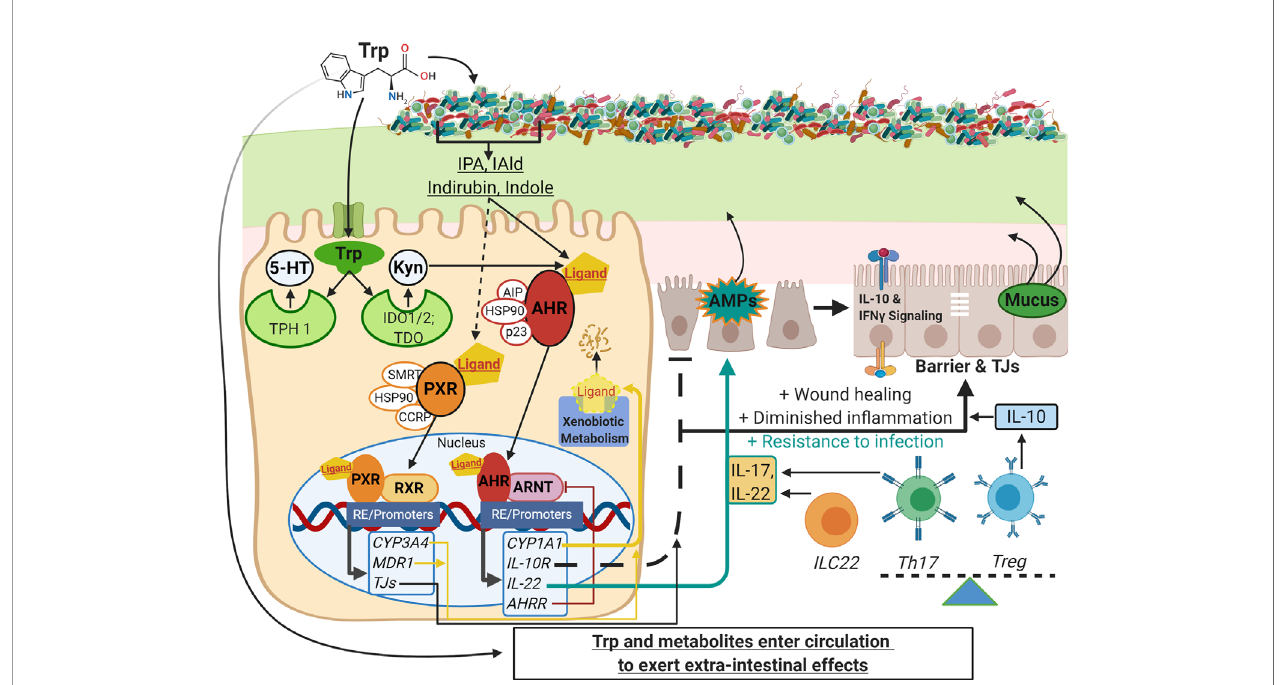
FIGURE 1 | Schematic of Trp metabolism, signaling pathways, and modulation of IEC and immune cell functions. On the left side, Trp enters host cells through various amino acid transporters and is metabolized endogenously: TPH1 (or TPH2 in the periphery) is the rate-limiting enzyme in conversion to 5-HT, and IDO and TDO enzymes convert Trp into Kyn. Gut microbes synthesize Trp de novo and convert this essential amino acid to numerous metabolites such as IPA, IAld, and indirubin. These metabolites, as well as endogenous Trp metabolites like Kyn, are shown to bind the ligand-activated transcription factor AHR and in some cases bind the transcription factor PXR. Both AHR and PXR are bound to chaperone proteins in the cytosol and ligand binding triggers nuclear translocation, heterodimer formation with either ARNT or RXR, respectively, and regulation of gene expression through heterodimer binding of response elements on various promoters throughout the genome (RE/Promoters). Genes upregulated by AHR and PXR include xenobiotic metabolizing enzymes (yellow lines), negative regulators (e.g. AHRR, red line), and effector molecules that modulate other pathways important in barrier function, dampening in fl ammation, and resistance to pathogens (black and teal lines; e.g. IL-10R, IL-22, IL-17). On the right side are other pathways involving IEC and immune cell functions that are in fl uenced by Trp metabolite signaling: TJ formation, AMP and mucus secretion, IFN- g signaling (in fl uences IDO1 expression, alters Kyn metabolism and IL-10R expression), and the differentiation of immune cell subsets that regulate in fl ammatory responses (e.g. Th17, Treg and ILC22 cells). This image was created in BioRender.com. Trp, tryptophan; IEC,intestinal epithelial cells; TPH, tryptophan hydroxylase; 5-HT, serotonin; IDO, indolamine 2, 3-dioxygenase; TDO, tryptophan 2,3-dioxygenase; Kyn, kynurenine;IPA, indole-3- propionic acid; IAld, indole-3-carboxaldehyde; AHR, aryl hydrocarbon receptor; PXR, pregnane X receptor; ARNT, AHR nuclear translocator; RXR,retinoid X receptor; AHRR, AHR repressor; TJ, tight junctions; AMP, antimicrobial peptides; Th and Treg, helper and regulatory T cells,